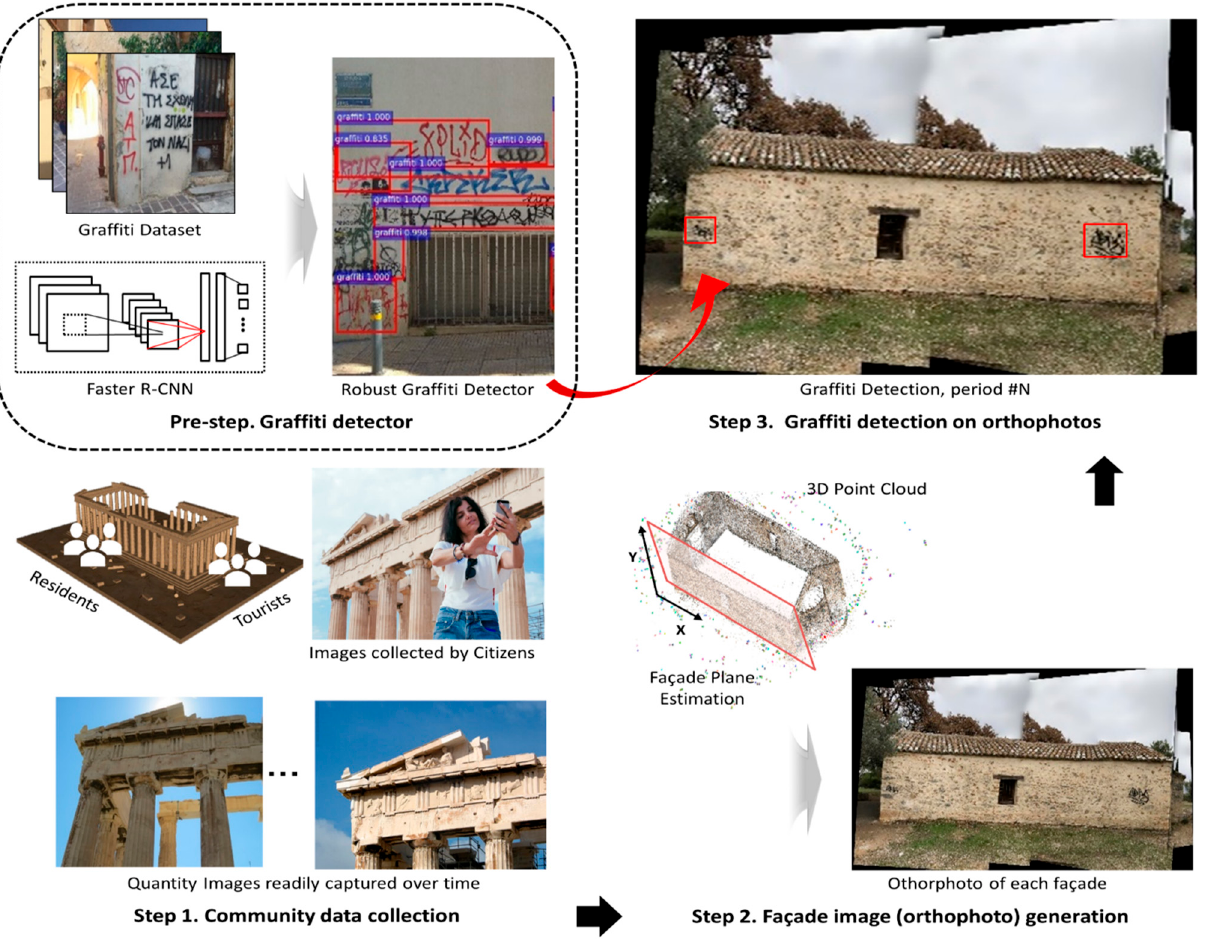
Figure 2. Overview of the technical approach. Prestep: develop a robust graffiti detector to exploit a graffiti database from STORM using Faster R-CNN; Step 1: collect images of target objects in a community (TOCs) periodically from ordinary citizens; Step 2: generate an orthophoto of each façade of a TOC by stitching and blending the collected images; Step 3: graffiti detection on orthophotos, including location and size of each graffiti.